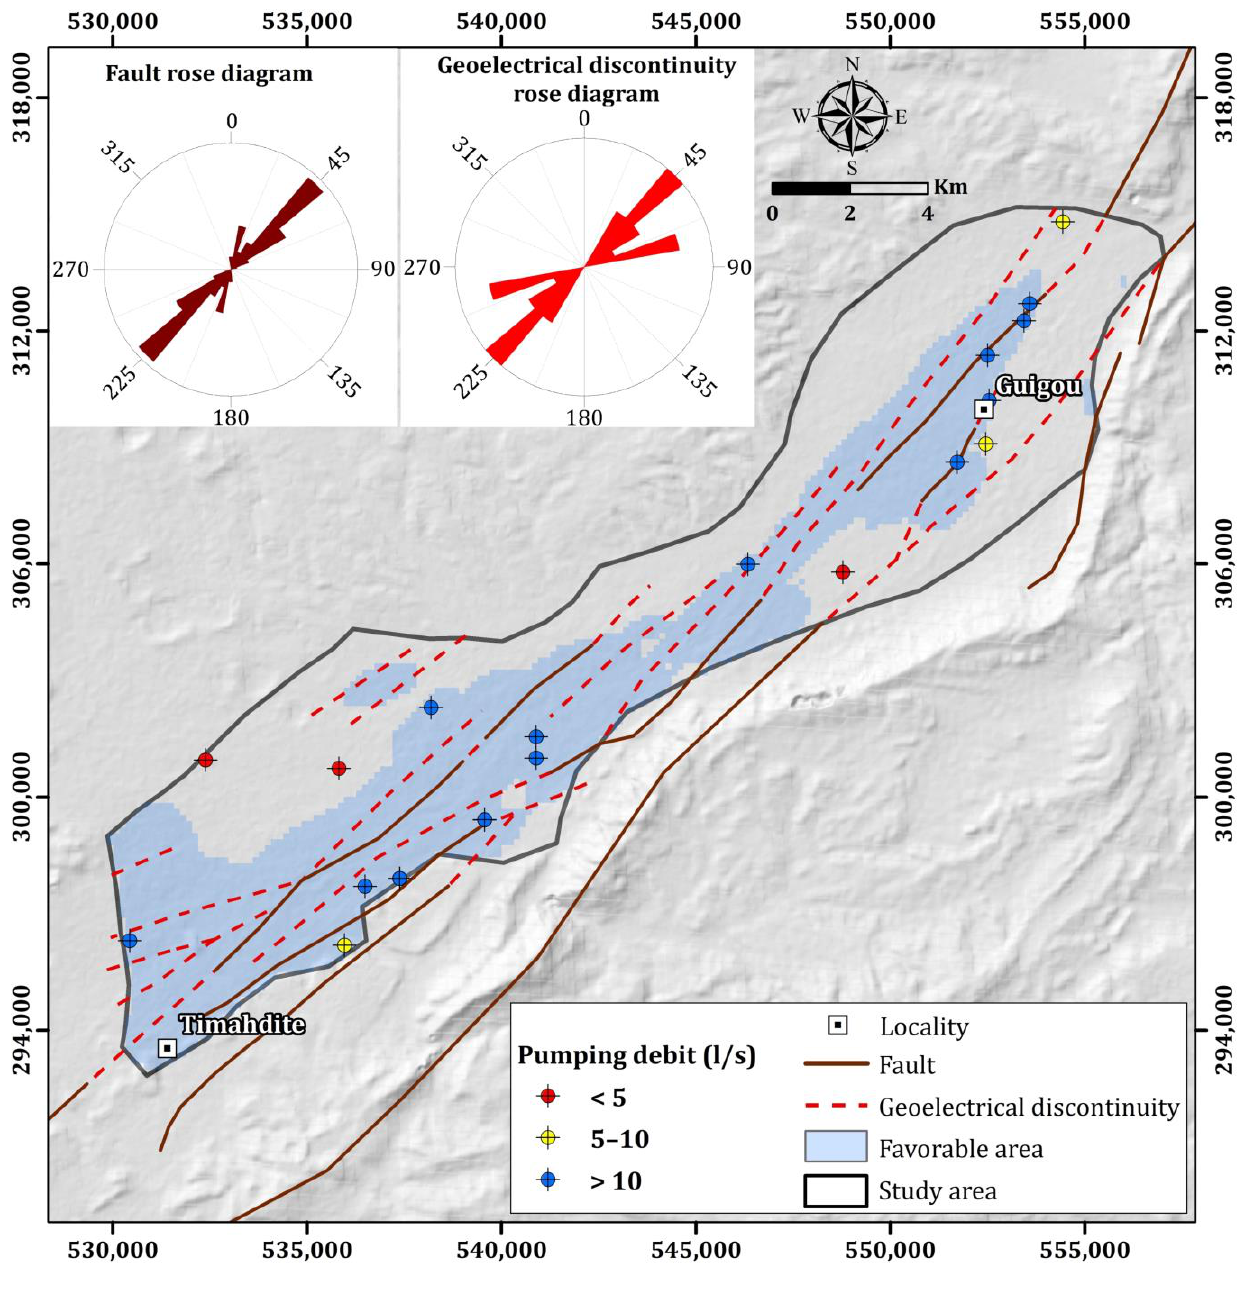
Figure 11. Aquifer prospectivity map showing the most favorable areas for